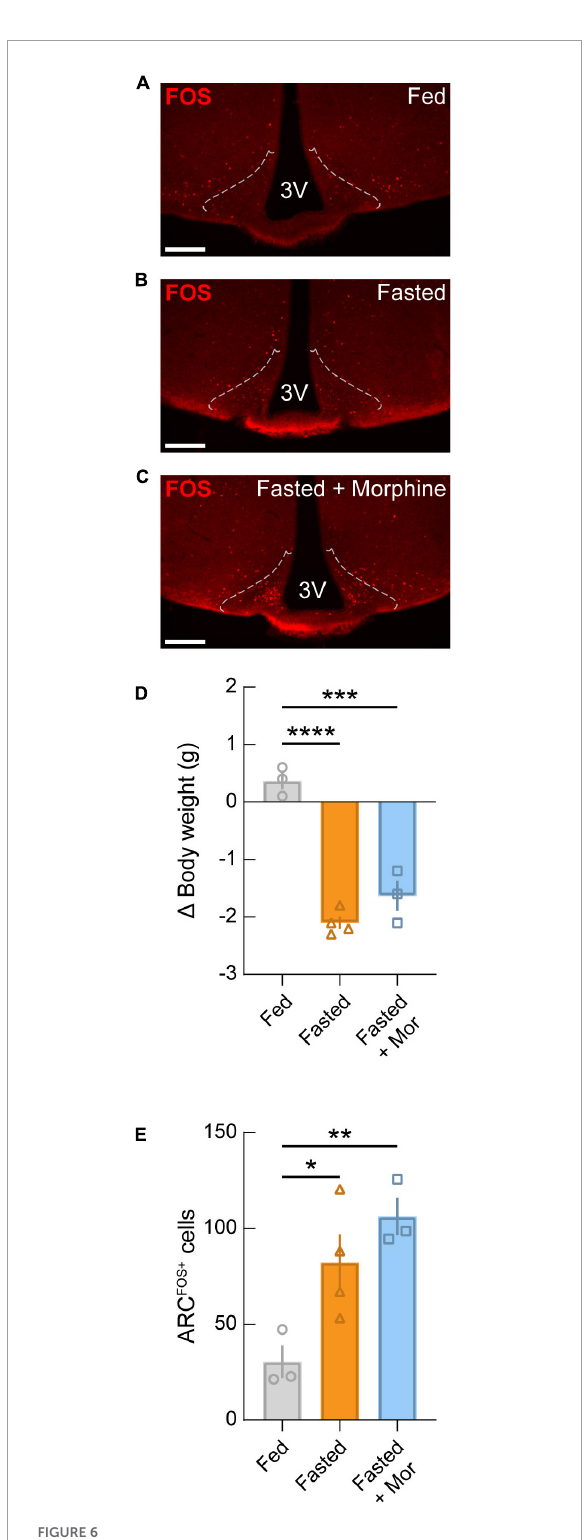
FIGURE6 Fasting-induced activation of the arcuate nucleus is not blocked by morphine administration. Representative images of FOS immunostaining from wild-type mice that were (A) fed, (B) fasted, and (C) fasted with morphine administration (20